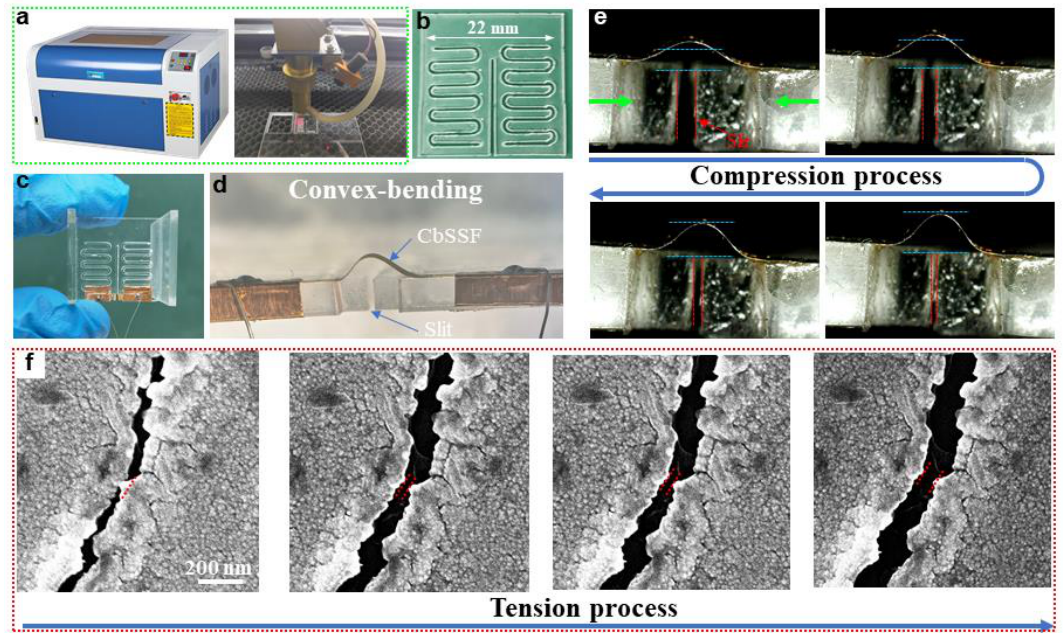
Figure 8. Preparation and characterization of slit-based mechano-sensor. ( a ) The slit-wake deformation and stress concentration on the slit tip with different slit lengths. ( b ) The substrate based on the optimal “hollow out” design strategy in Figure 5g. ( c ) The bio-inspired slit-based mechano-sensor. ( d ) The FUCMSS covering the slit wake in convex-bending mode. ( e ) The bending of FUCMSS with the change in slit width. ( f ) The change in nanoscale crack width with the bending of